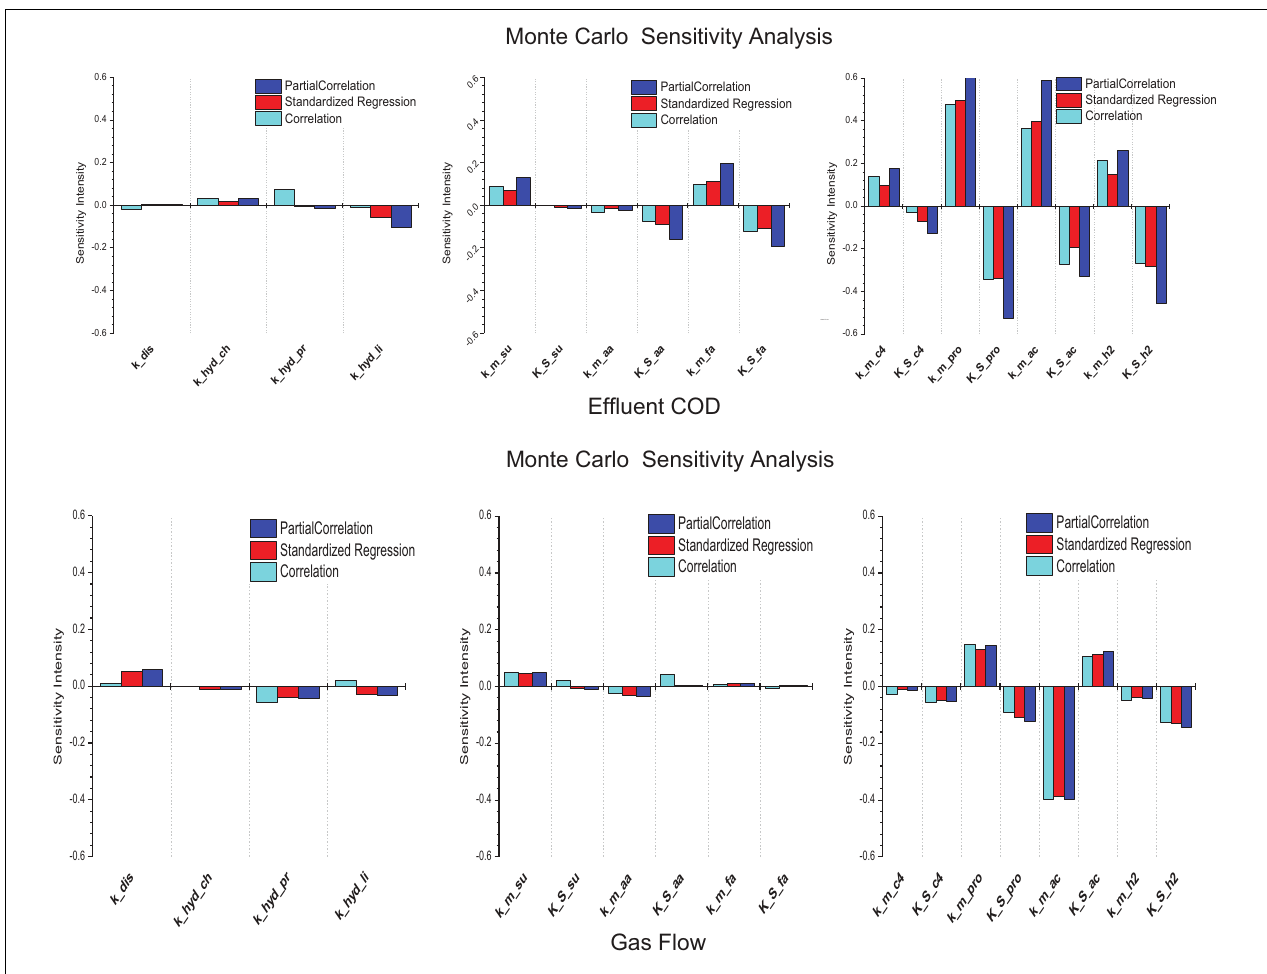
FIGURE 2 | Schematic of sensitivity analysis result of 18 kinetic parameters relating to COD eff and biogas flow of AD system. Monte Carlo of Partial Correlation, Standardized Regression and Correlation for every parameter were respectively implemented in the sensitivity analysis.